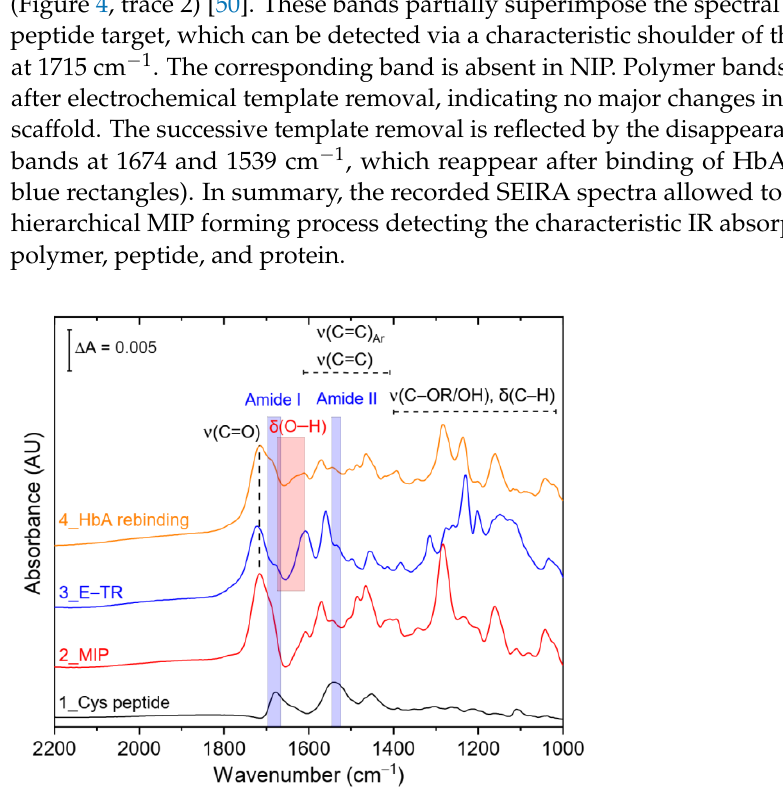
Figure 4. IR absorbance spectra of HbA binding to the hierarchical MIP on a SEIRA active gold electrode. Traces 1 to 3 display the individual steps of the MIP-formation. Trace 4 shows a rebinding using 500 µ L of 1 µ M HbA solution. HbA binding is confirmed by the detectability of amides I and II bands (blue rectangles). The red rectangle marks the broad O-H bending ( δ ) modes, centered at 1640 cm − 1 , resulting from the permeability of the MIP film for water molecules via empty binding cavities